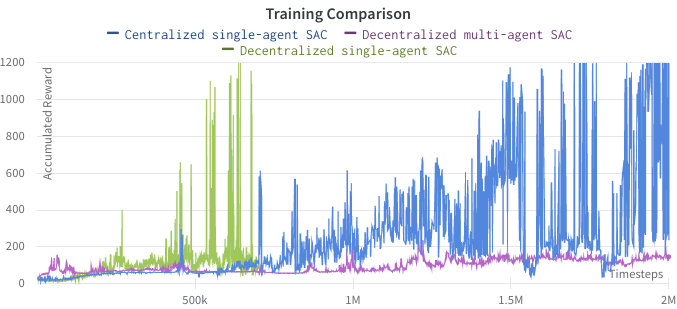
Figure 15. Comparison of accumulated reward for the centralized and decentralized SAC agents. Created with ❤ on Weights & Biases.